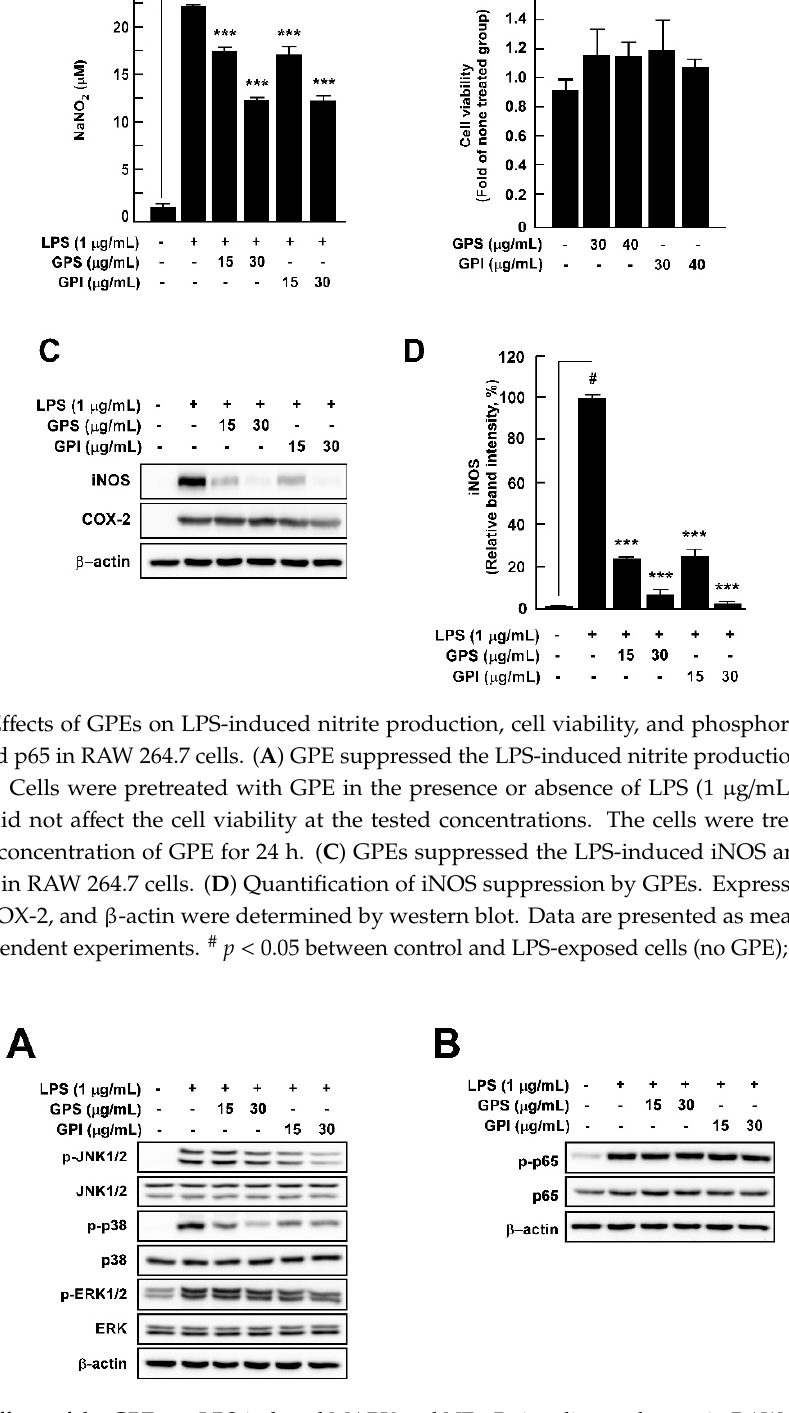
Figure 3. E ff ects of the GPEs on LPS-induced MAPK and NF- κ B signaling pathways in RAW 264.7 cells. ( A ) GPEs suppressed the LPS-induced phosphorylation of JNK1 / 2, p38, and ERK1 / 2 in RAW 264.7 cells. ( B ) GPEs did not a ff ect the LPS-induced phosphorylation of p65 in RAW 264.7 cells. Cells were treated with the indicated concentrations of GPEs and then stimulated with LPS (1 µ g / mL). The levels of phosphorylation and expression were detected by western